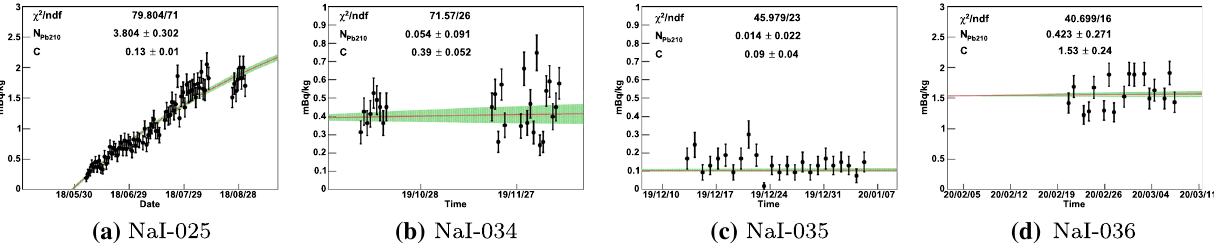
Fig. 9 Thetotalalpharatesinthecrystalsasafunctionoftimearemod- eled as a contamination of 222 Rn (and/or 210 Pb) at the crystal growth dates described in the text. Here black points are data, red-solid lines are the best fit models, and green bands are 1 σ uncertainty regions of the fit. a An increase in the alpha rates corresponding to the 210 Po lifetime is evident in NaI-025. No significant increases in alpha rates indicate